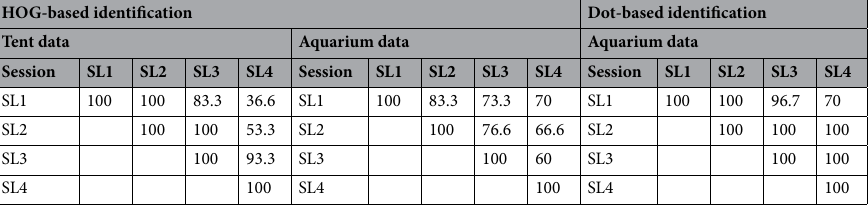
Table 1. The accuracy of automatic identification using hog descriptor of the pattern and dot approach. The accuracy in % is shown for the combinations of the SL